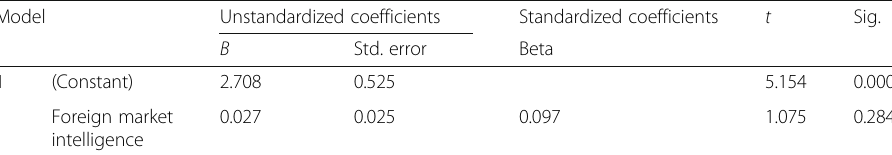
Table 15 Regression coefficients Model